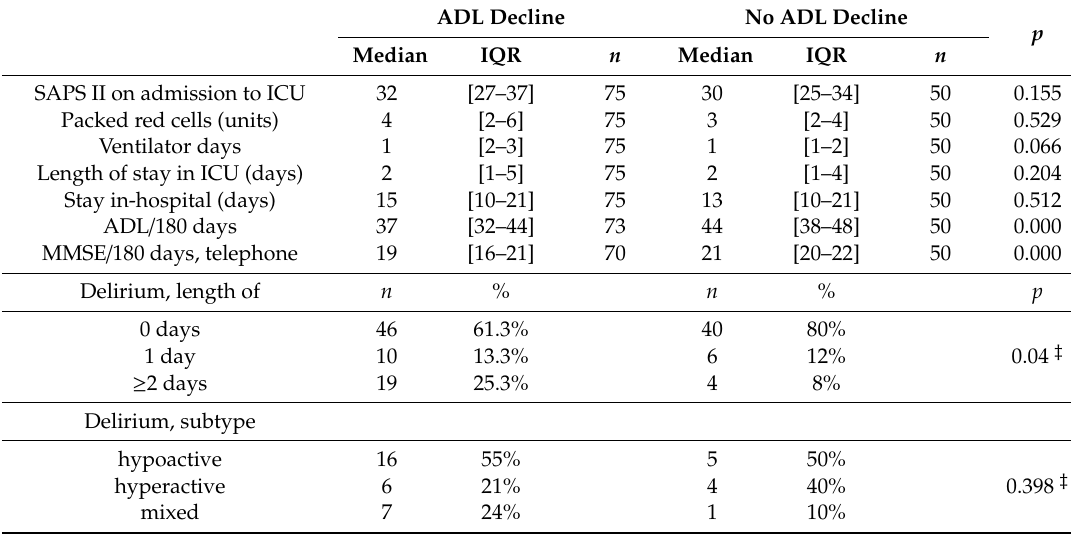
Table 3. Postoperative